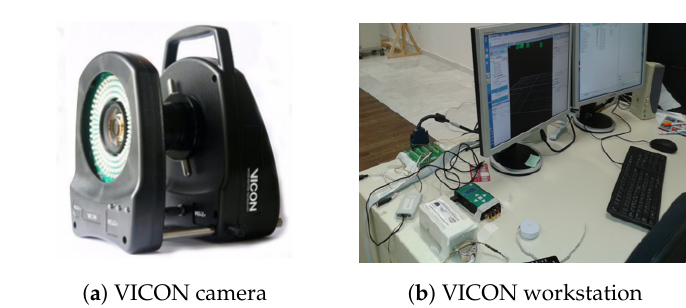
Figure 3. Pictures of VICON components